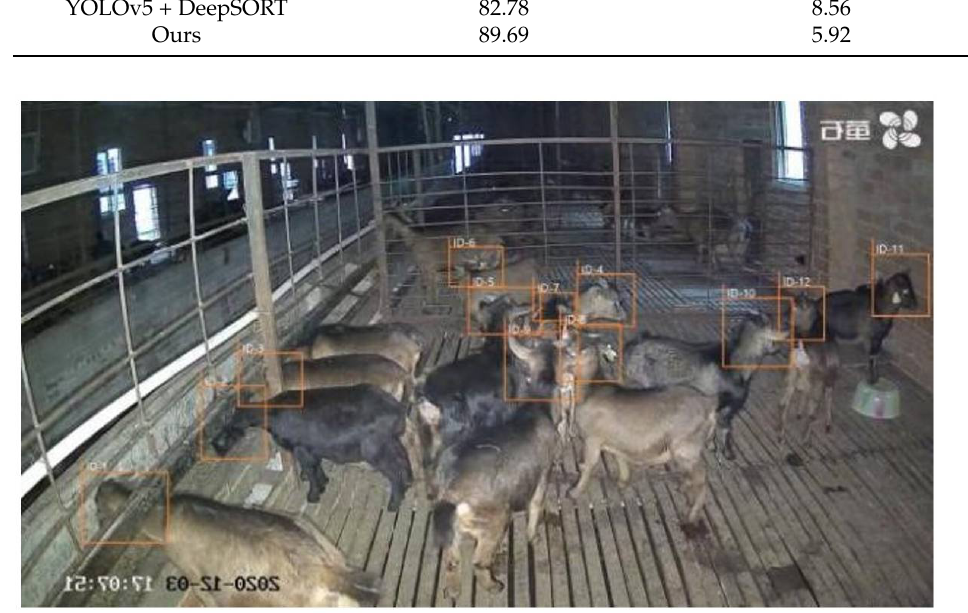
Figure 14. The results of goat tracking.